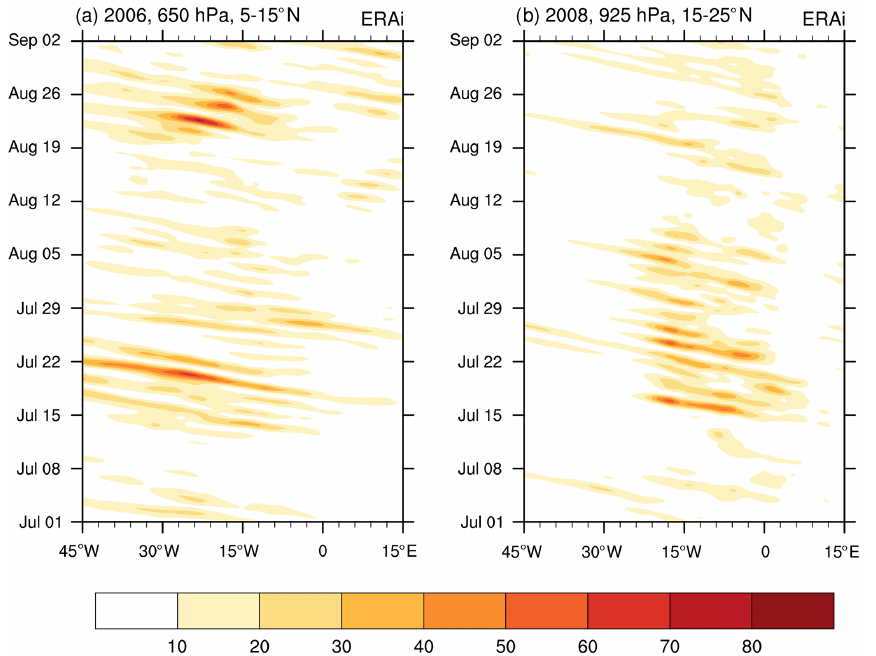
Figure 1. Hovmöller diagram of eddy kinetic energy (Jkg − 1 ) from ERAI for July–August for the year (a) 2006 at 650hPa, averaged over 5–15 ◦ N, and (b) 2008 at 925hPa, averaged over 15–25 ◦